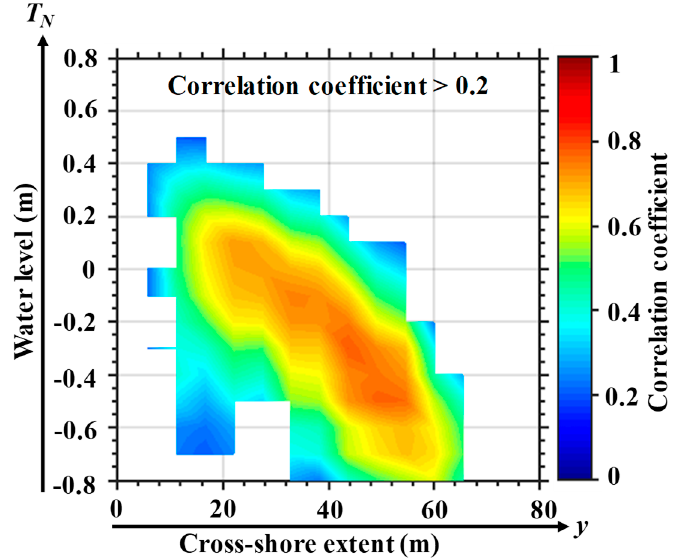
Figure 8. The distribution of correlation coefficients for different tidal signals ( − 0.8 to 0.8 m) and cross- shore positions 0 (cid:3409) 𝑦 (cid:3409) 80 𝑚 at 𝑥 (cid:3404) (cid:3398)49 m during 17–30 June 2005. cross-shore positions 0 ≤ y ≤ 80 m at x = − 49 m during 17–30 June